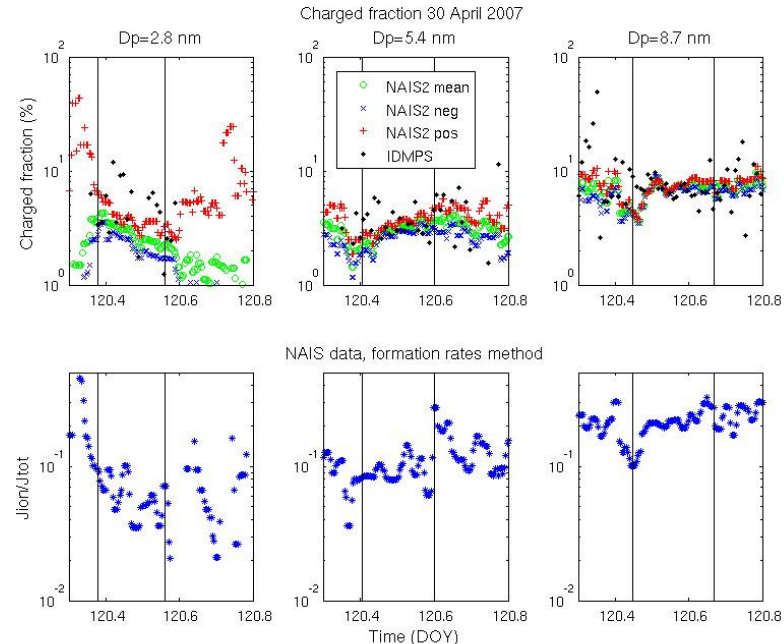
Figure 7. Time evolution of the charged fraction of particles in three different size bins (top panels) based on NAIS and Ion-DMPS measurements at Hyytiälä on 30 April 2007. The lower panels depict the ratio between the charged and total particle production rate determined from the NAIS data at the corresponding size bins. The period during which the nucleation event effectively affects each size bin is separated by vertical bars in the figures.